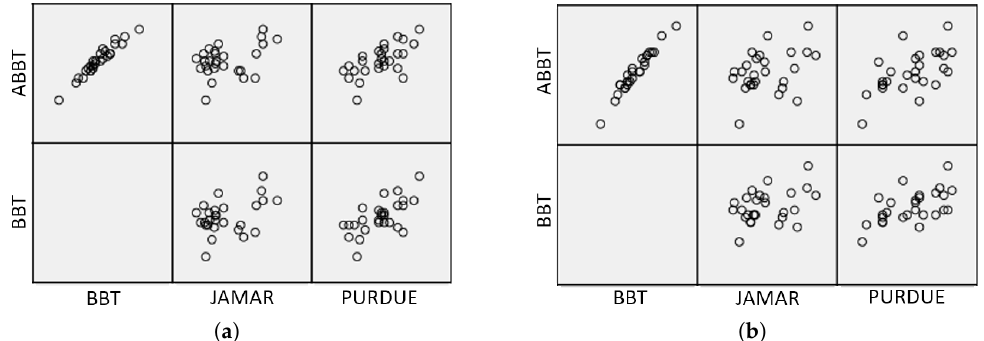
Figure 10. Correlation plot among three outcomes commonly used for upper limb functional assessment: ( a ) for the dominant hand, and ( b ) non-dominant